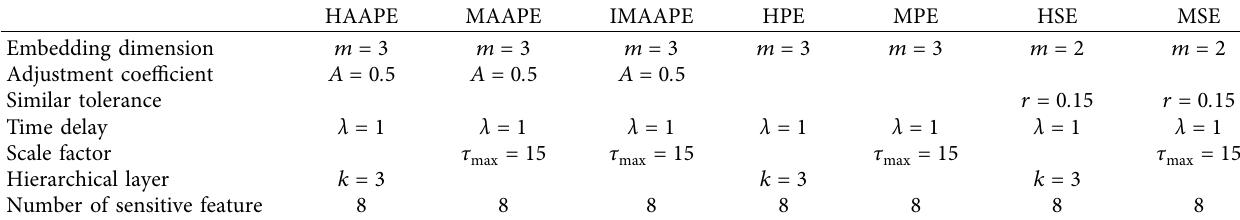
Table 3: Parameters settings for different methods.